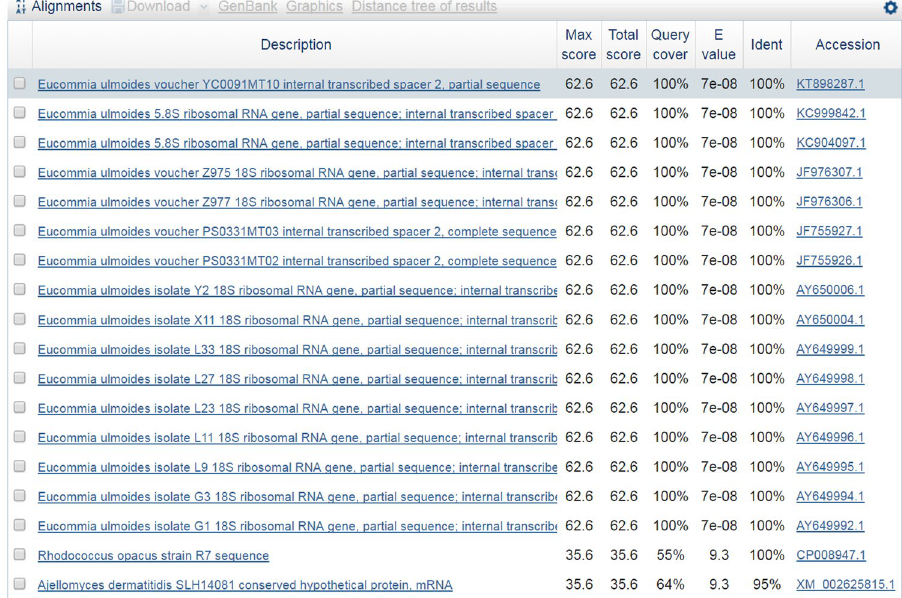
3 Scientific RepoRts | 7: 5858 | DOI:10.1038/s41598-017-05892-y